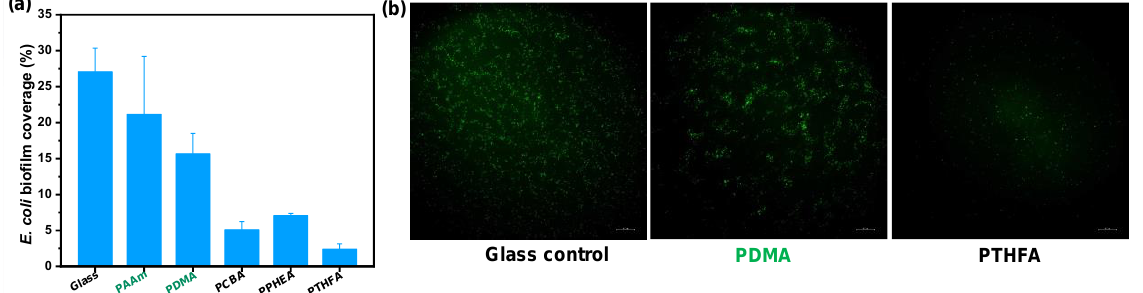
Figure 5. E. coli bacteria biofouling evaluation of typical hydrogels obtained by ( a , b ) the direct sol- vent exchange of as-prepared organo-gels after polymerization, and ( c , d ) the solvent exchange of organo-gels with equilibrium state in DMSO after incubation for 48 h in E. coli suspension. ( a , c ): Image analysis results (% biofilm coverage) of various surfaces: statistical analysis of the mean flu- orescence intensity. ( b , d ): Typical fluorescence microscopy images of algae biofouling on hydrogels.